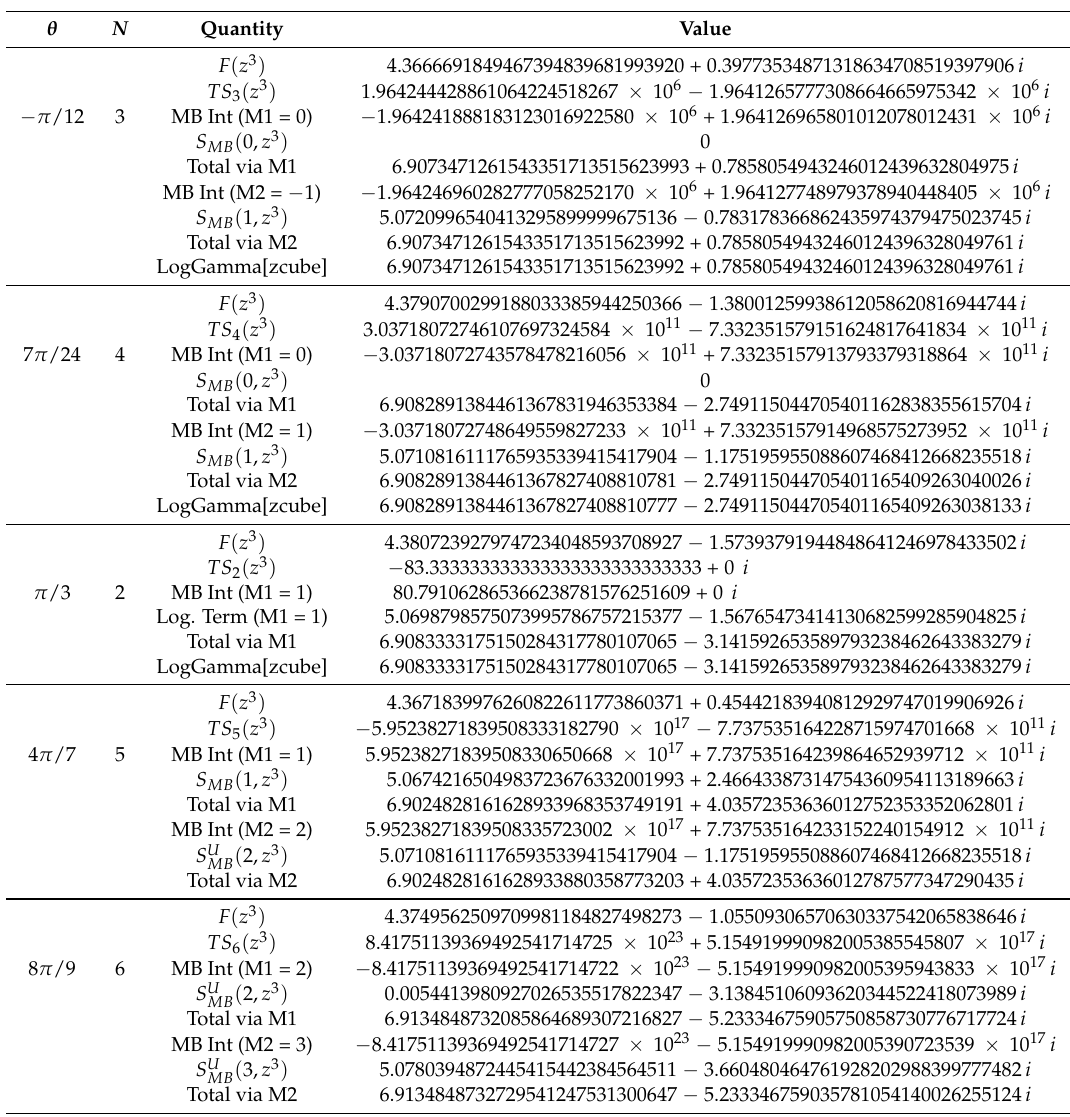
Table 6. Values of ln Γ ( z 3 ) with (MB)-regularized